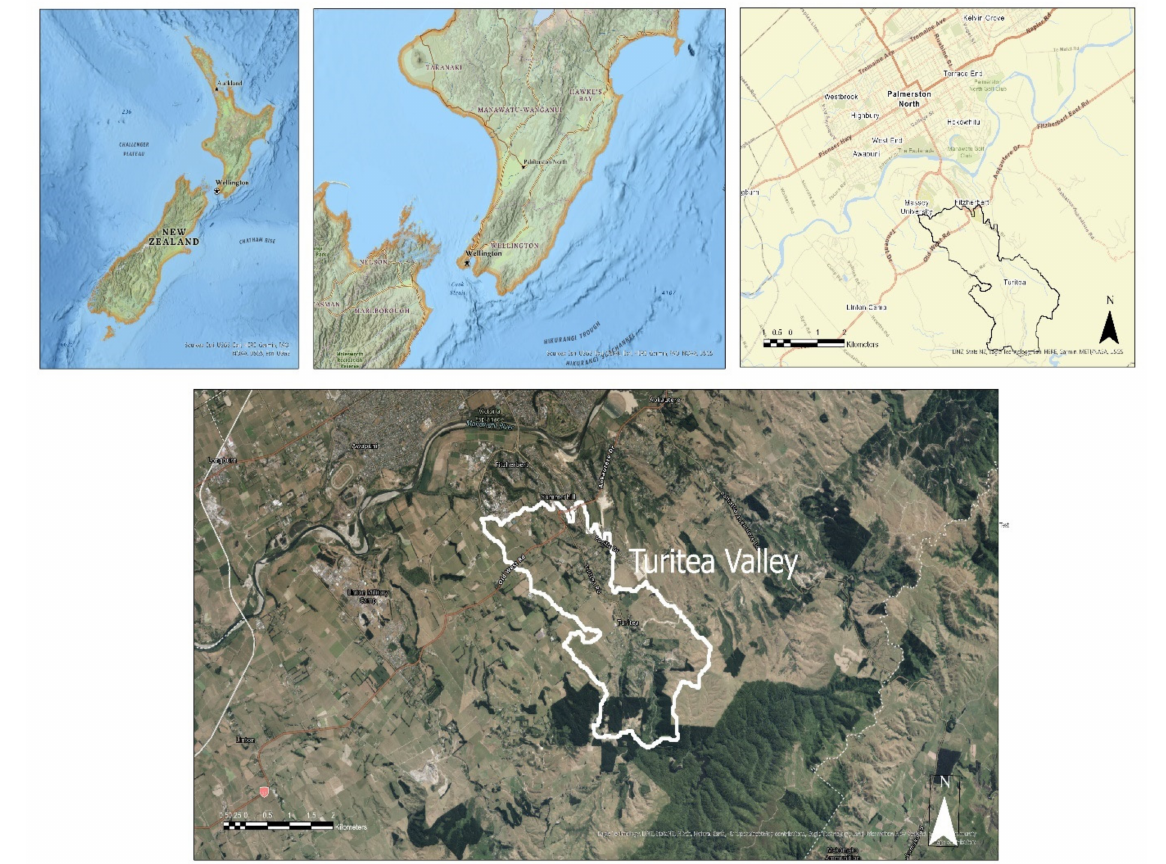
Figure 1. Map showing Palmerston North and the Turitea Valley study